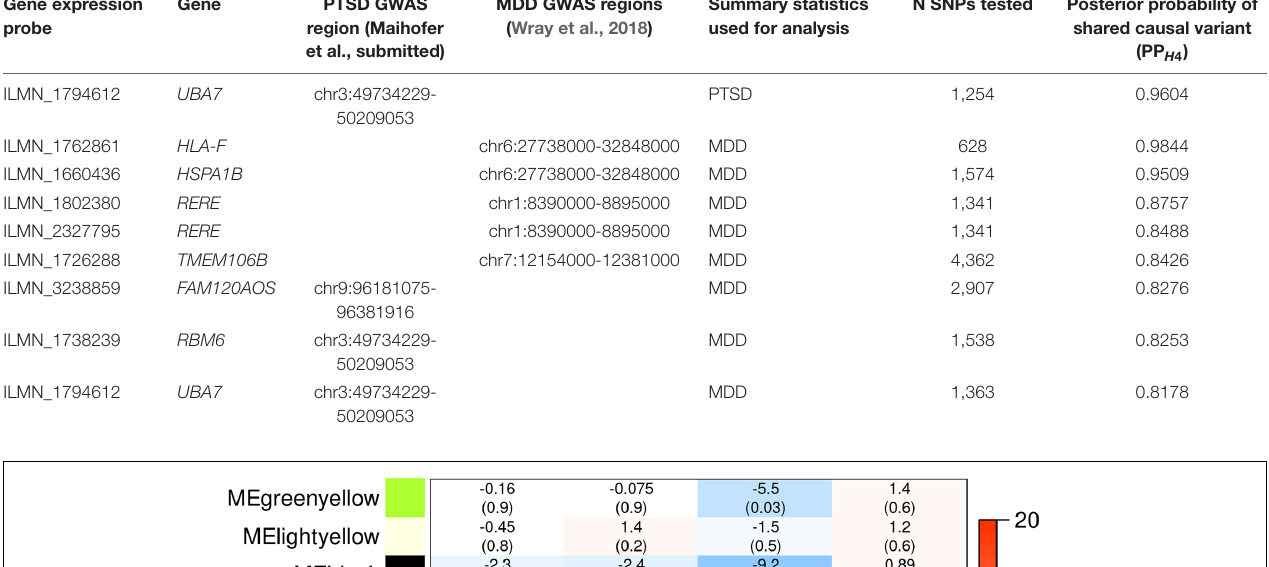
TABLE 2 | Colocalization of eQTLs in NHW MIRECC/Duke subset and either PTSD or MDD associated GWAS regions (PP H 4 > 0.8). Gene expression probe